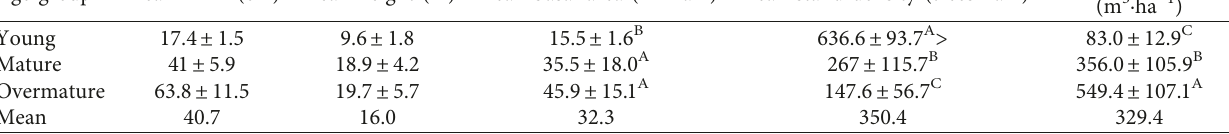
Table 2: Growing stock characteristics of Chir Pine forest.